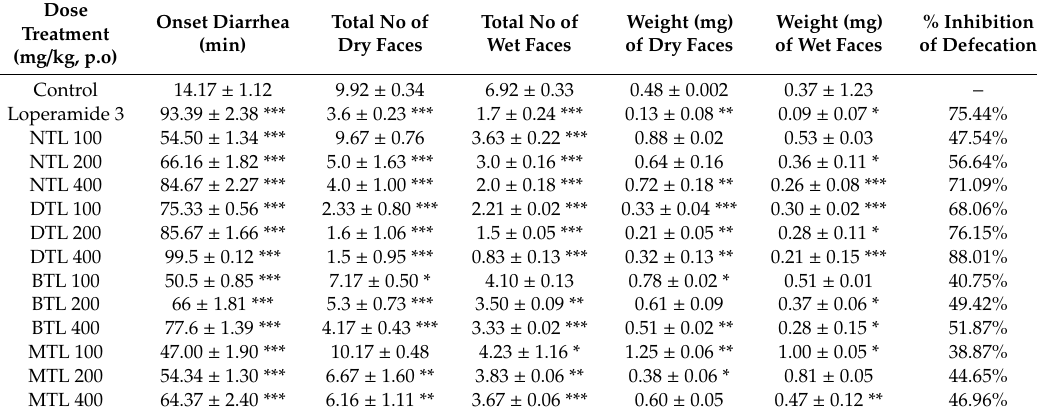
Table 2. E ff ect of methanol extract of T. leucostaphylum leaves and its derived fractions on castor oil induced diarrhea in mice. Dose